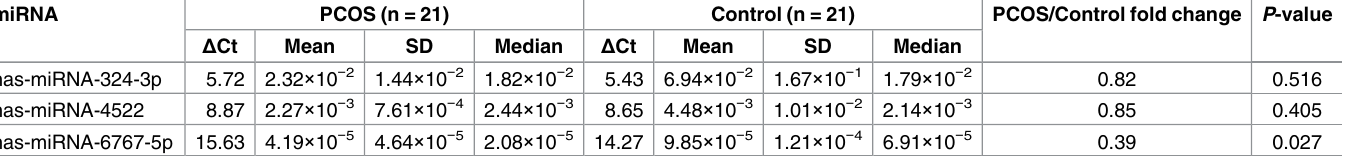
Table 2. Relative expression of serum miRNAs between women with PCOS and control subjects (2 - Δ Ct ). miRNA PCOS (n =